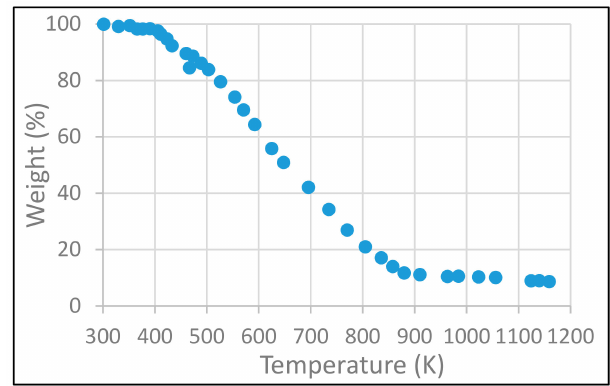
Figure 2. Thermogravimetric analysis (TGA) of Ru / CNT in air. Table 1. Elemental analysis of samples by energy-dispersive X-ray spectroscopy (EDX). C O Fe Ni Ru Raw CNTs